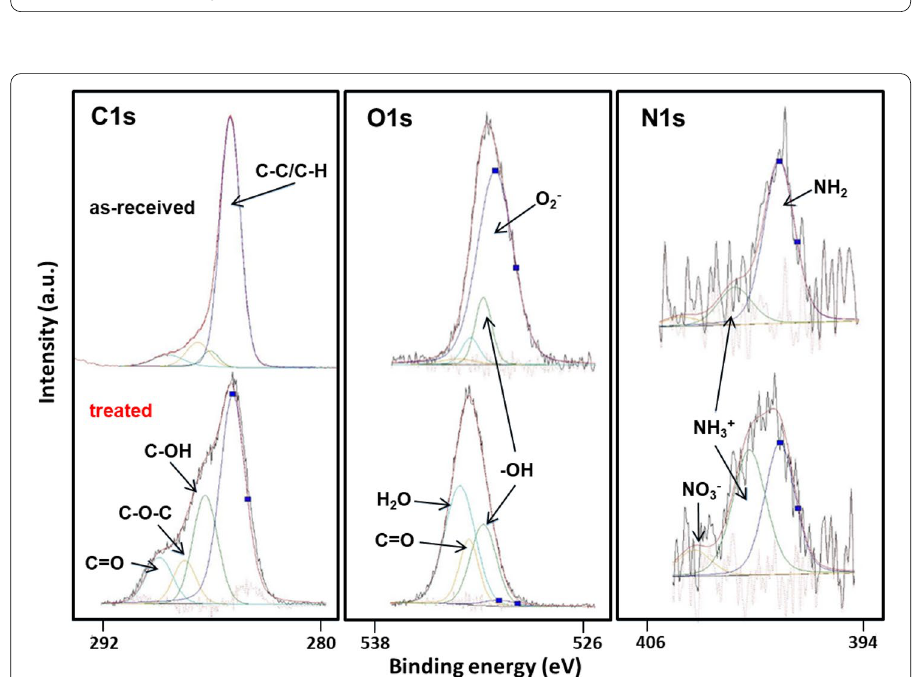
Fig. 5 XPS spectra of muslin fabric before (top) and after (bottom) treatment, showing the deconvolution of the C1s, O1s and N1s photoelectron